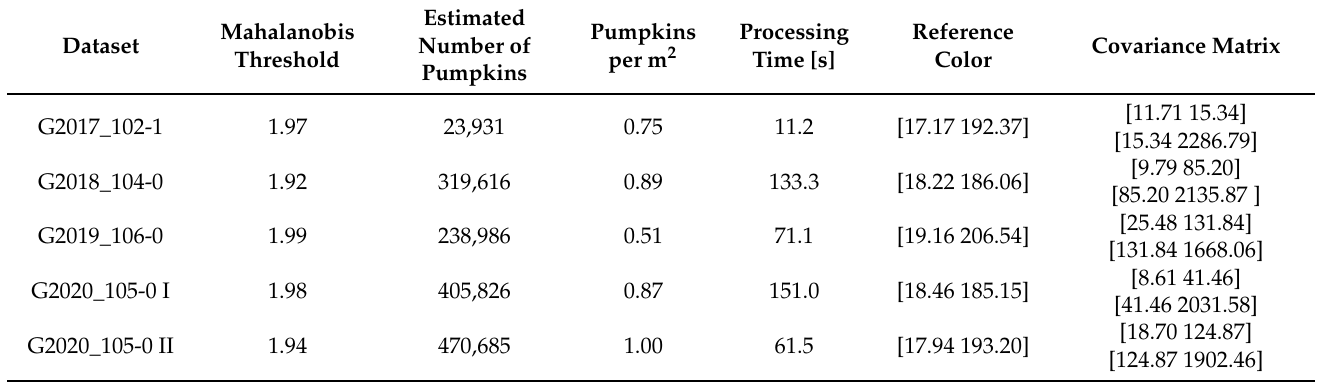
Table 3. Numerical results for all